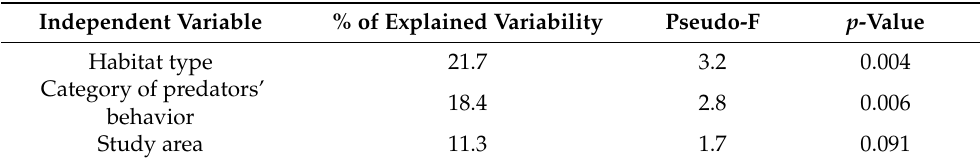
Figure 2. Cumulative proportion of surviving nests within forest edge ( a ), forest interior ( b ), and forest clearings ( c ) separately for Jesen í ky and Ore Mts. Kaplan–Meier method was used to fit the survival curves, complete (predated) and censored (non-predated) nests are indicated. Table 3. The relationships between tested independent variables and distribution of recorded events by artificial nests by each predator species. Canonical correspondence analysis, n = 82 recorded